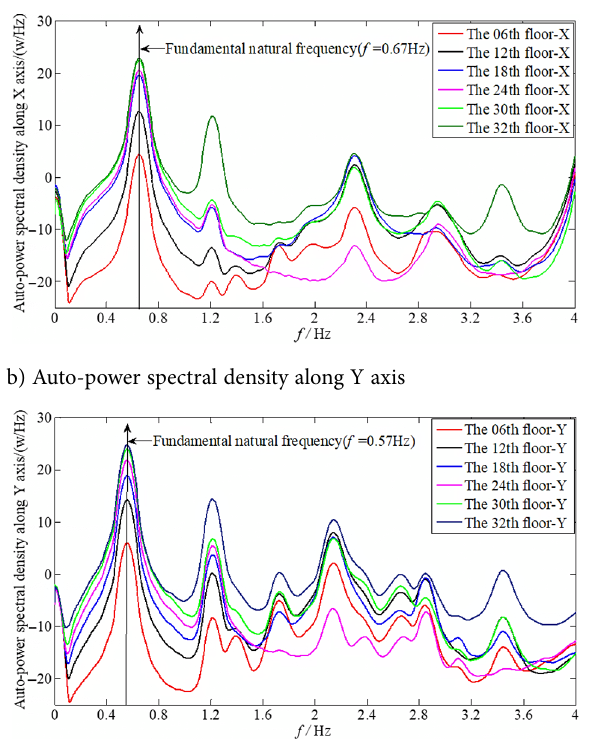
Figure 8. Measured power spectral density functions along both the X and Y